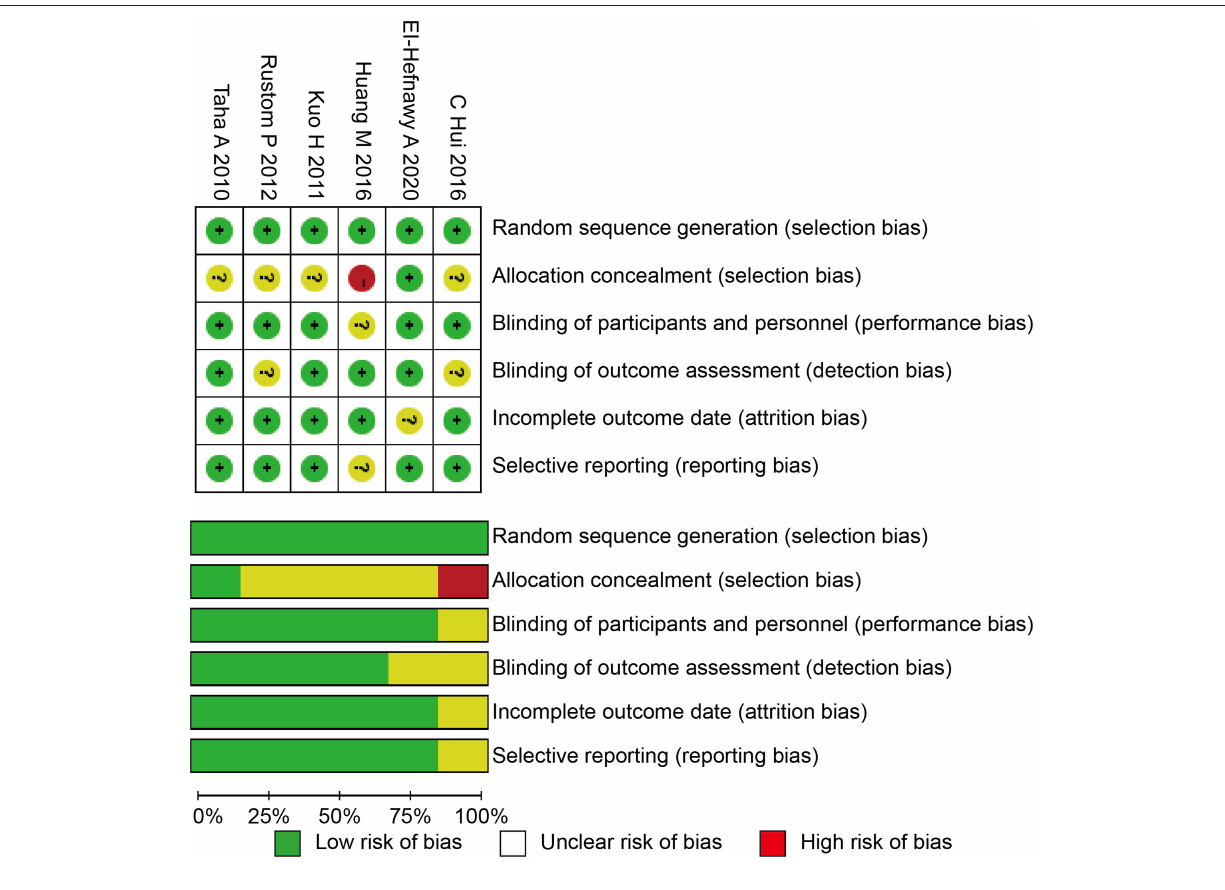
FIGURE 1 | Risk of bias summary and graph. RCT, randomized controlled